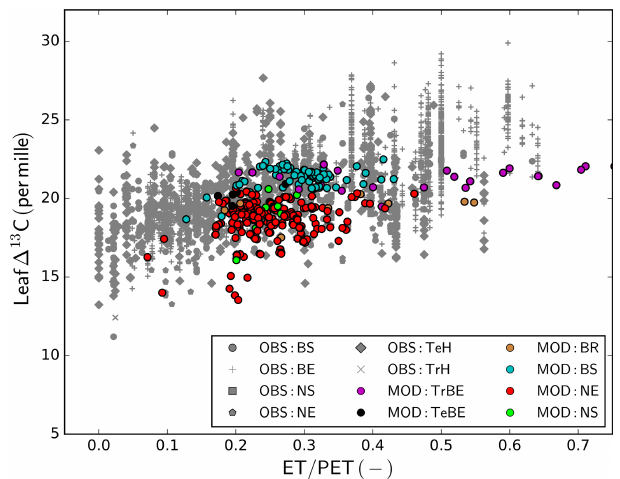
Figure 7. Observed and simulated leaf (cid:49) 13 C. Observations are taken from the global database of Cornwell et al. (2018b); simu- lations are derived from the GFDB set of sites (see Fig. 2). As there is no direct correspondence between data and model location, the data are plotted as a function of climatic water deficit, measured as the ratio of actual to potential evapotranspiration (ET / PET). For model PFT abbreviations, see Table 1.